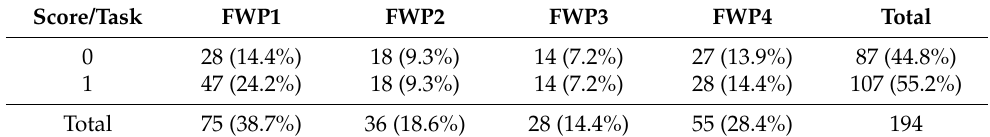
Table 4. Frequency (percentage) of participants according to the score for each fraction word problem.